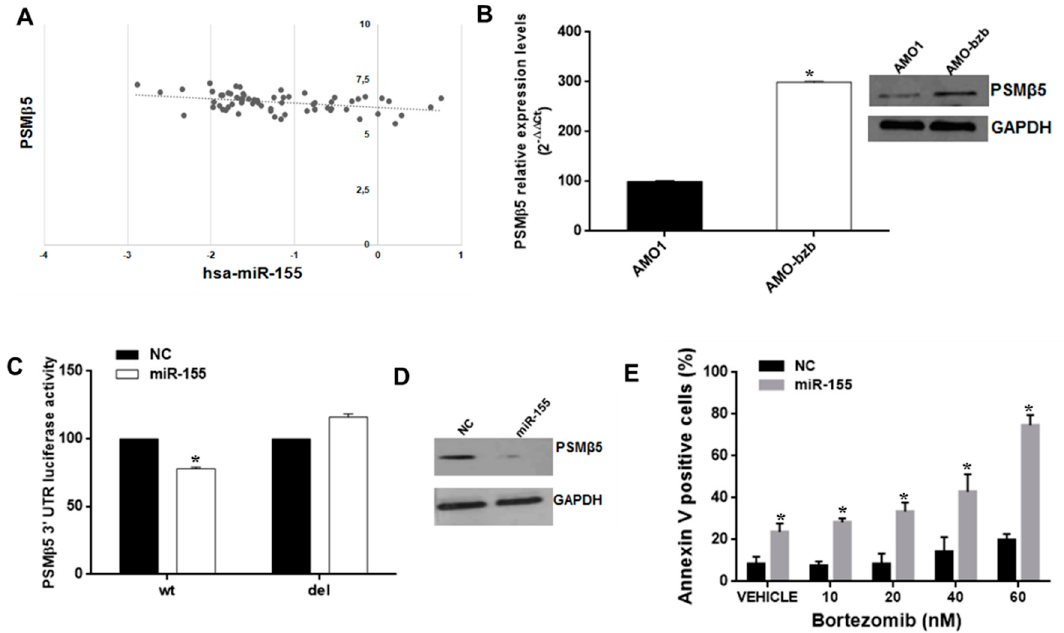
Figure 5. The miR-155 targets PSM β 5 and sensitizes the AMO-bzb cell line to bortezomib. ( A ) Inverse correlation between miR-155 and PSMB5 levels in MM patient plasma cells (Gene Expression Omnibus accession number GSE16558; R 2 = 0.15, p = 0.0015). ( B ) Quantitative RT-PCR and WB analysis of PSM β 5 using total RNA or total protein lysates respectively from AMO1 and AMO-bzb. Raw Ct values were normalized to GAPDH housekeeping gene and expressed as percentage of AMO1 cell line. Values represent mean of three different experiments. For the immunoblot of PSM β 5 in AMO1 and AMO-bzb, GAPDH was used as loading control. ( C ) Dual luciferase assay in AMO-bzb cells co-transfected with firefly luciferase constructs containing the 3 (cid:48) UTR of PSM β 5 or a deleted 3 (cid:48) UTR construct, and miR-155 or scrambled oligonucleotides (NC) as indicated. The firefly luciferase activity was normalized to renilla luciferase activity. The data are shown as relative luciferase activity of miR-155-transfected cells as compared to the control (NC) of a total of six experiments from three independent transfections. ( D ) Immunoblot of PSM β 5 in AMO-bzb MM cells, 72 h after transfection with synthetic miR-155 or scrambled oligonucleotides (NC). Loading control was performed using GAPDH. ( E ) Apoptosis evaluation of AMO-bzb cells transfected with synthetic miR-155 or scrambled oligonucleotides (NC), 72 h after treatment with different doses of bortezomib; * p < 0.05 as compared to NC-transfected